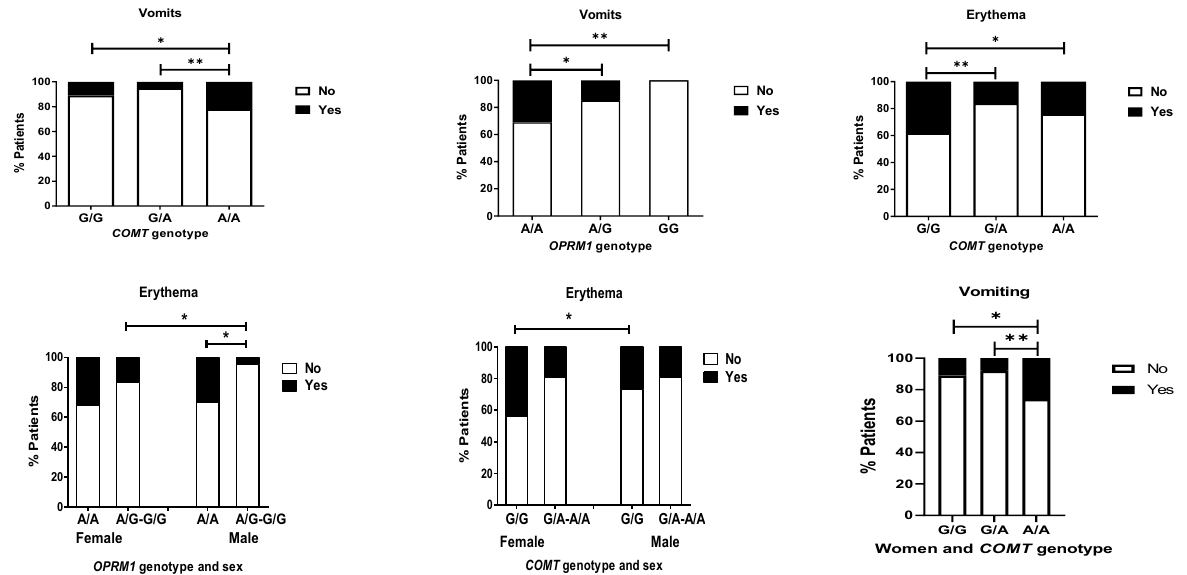
Figure 4. Difference of frequency of vomiting and erythema adverse events depending on COMT and OPRM1 gene variants in oxycodone/naloxone case